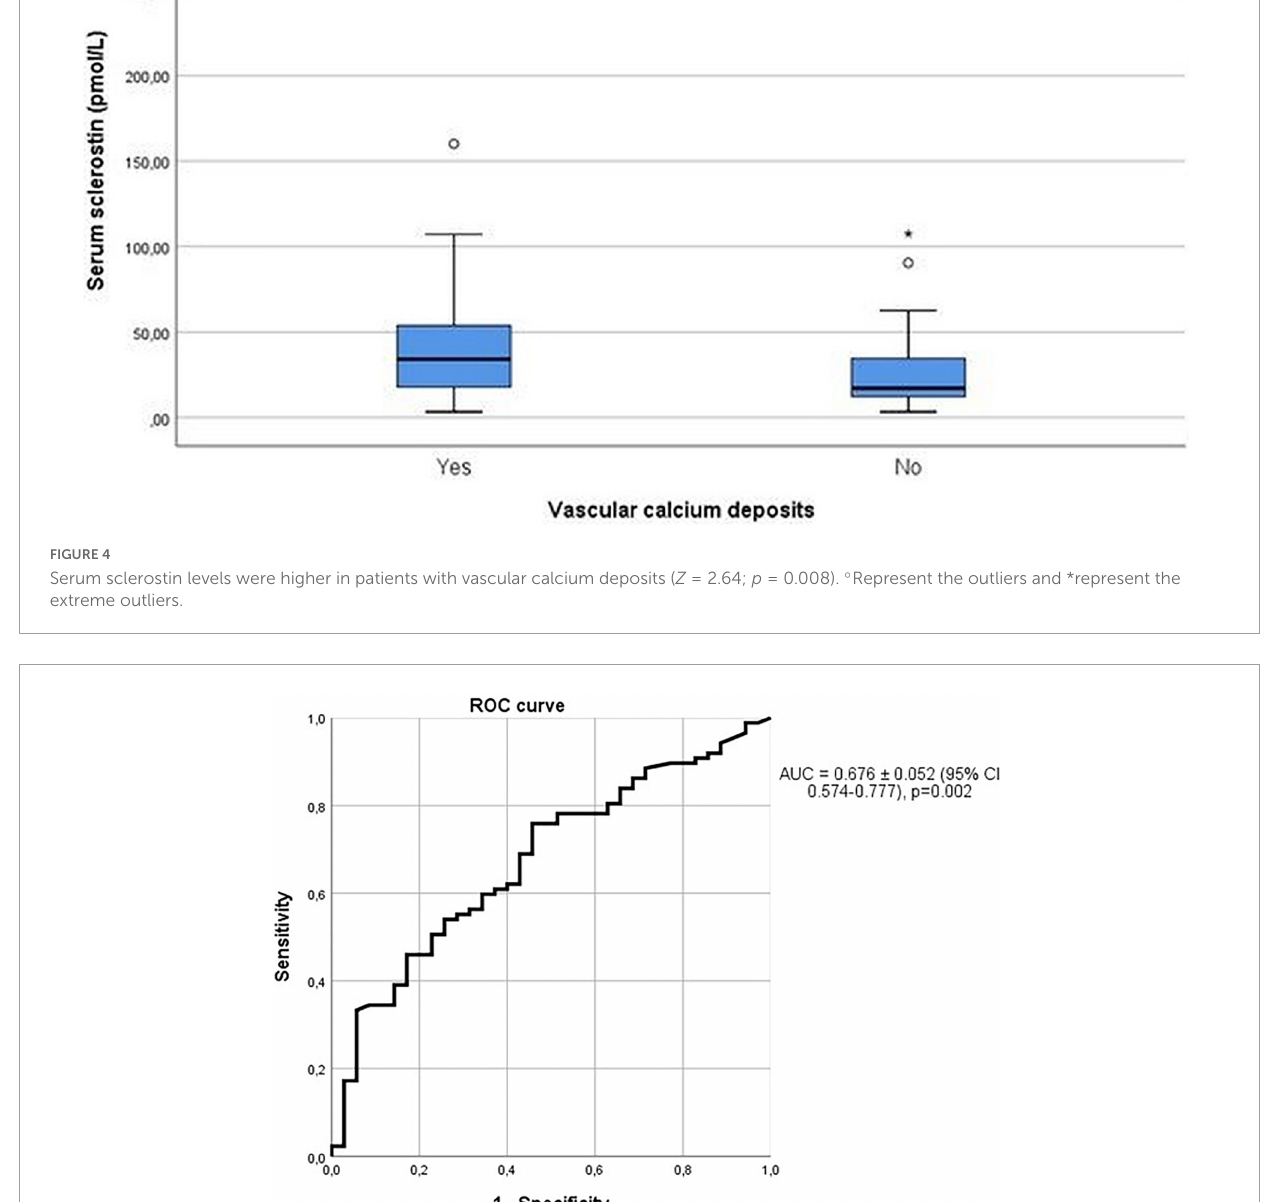
In hypertensive patients, the ROC curve comparing sclerostin and cella media index was not statistically significant (AUC = 0.588 ± 0.095; 95% CI = 0.401–0.775; p = 0.31), but considering only non-hypertensive patients, ROC curve analysis yielded an AUC even greater [0.743 ± 0.060 (95% CI = 0.626–0.861; p = 0.001)] than that observed in the whole group, as shown in the Figure 12 . Therefore, when hypertension is present, the relationship of sclerostin with brain atrophy is less